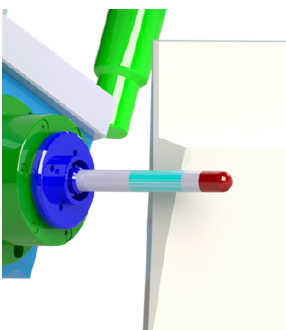
Figure 7. The situation of robotic milling on the workpiece.